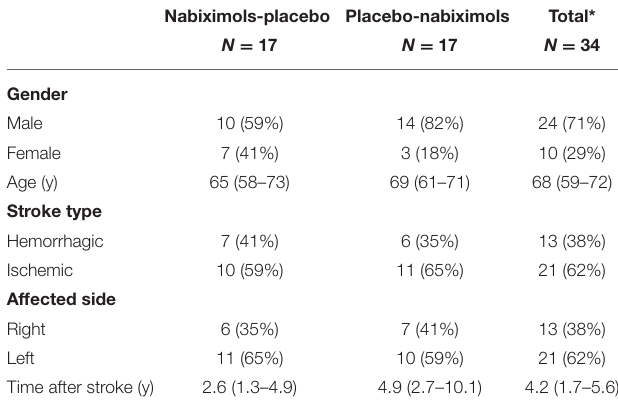
TABLE 1 | Baseline patient